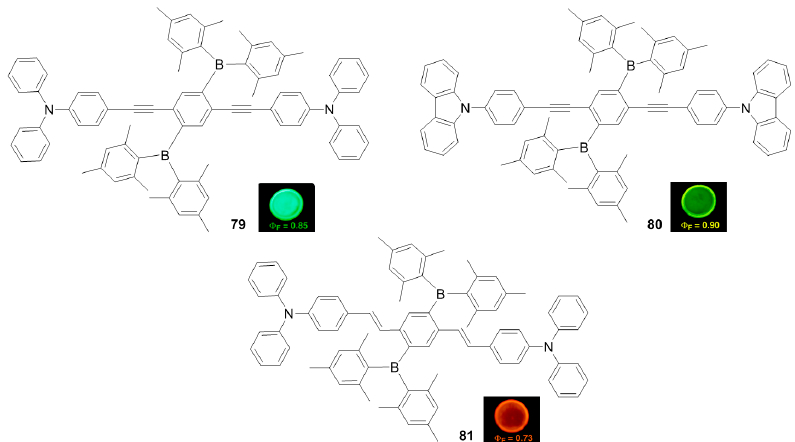
Figure 13. Triarylborane-substituted π -conjugated materials 79 – 81 .